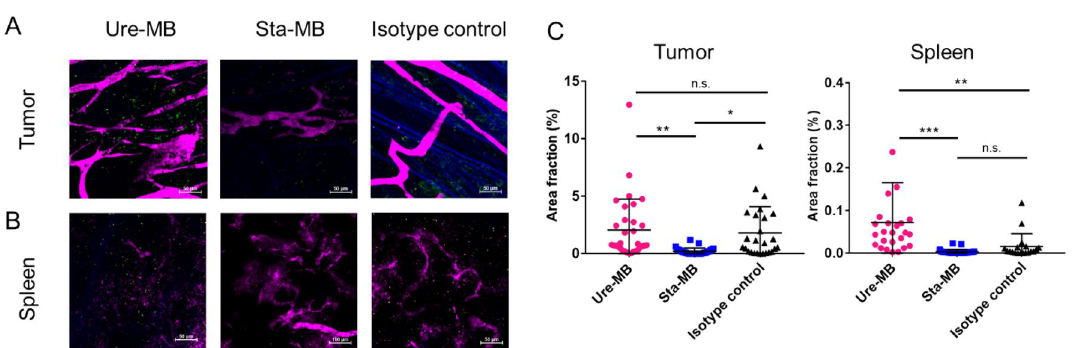
Figure 4. Detection of switch and nonswitch antibody-binding cells by two-photon microscopy. An Alexa Fluor 488-labeled isotype control antibody, Ure-MB or Sta-MB was administered twice at a dose of 1 mg/kg. Intravital imaging by two-photon microscopy was conducted the day after the second administration. ( A,B ) Representative images of Alexa Fluor 488-labeled antibody distribution in ( A ) tumor and ( B ) spleen tissues. To visualize blood vessels, Qtracker 655 vascular labels were intravenously administered just before observation by two-photon microscopy. Green, Alexa Fluor 488-labeled antibody; magenta, blood vessels; blue, collagen fibers. ( C ) Quantitative analysis of Alexa Fluor 488-labeled antibody fluorescence. The antibody-binding regions in the tumor and spleen were detected from images of three or four mice. **p < 0.01, ***p < 0.001 by Tukey’s multiple comparisons